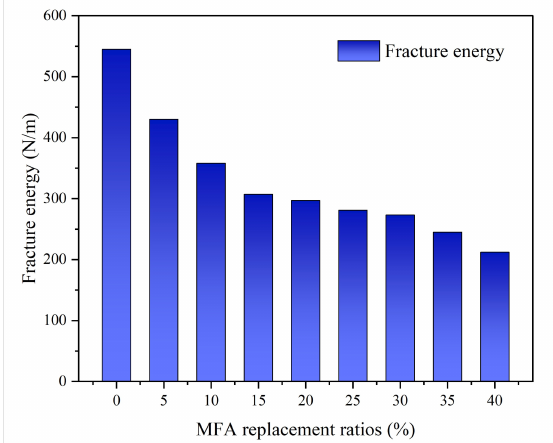
Figure 12. Fracture energy versus MFA replacement